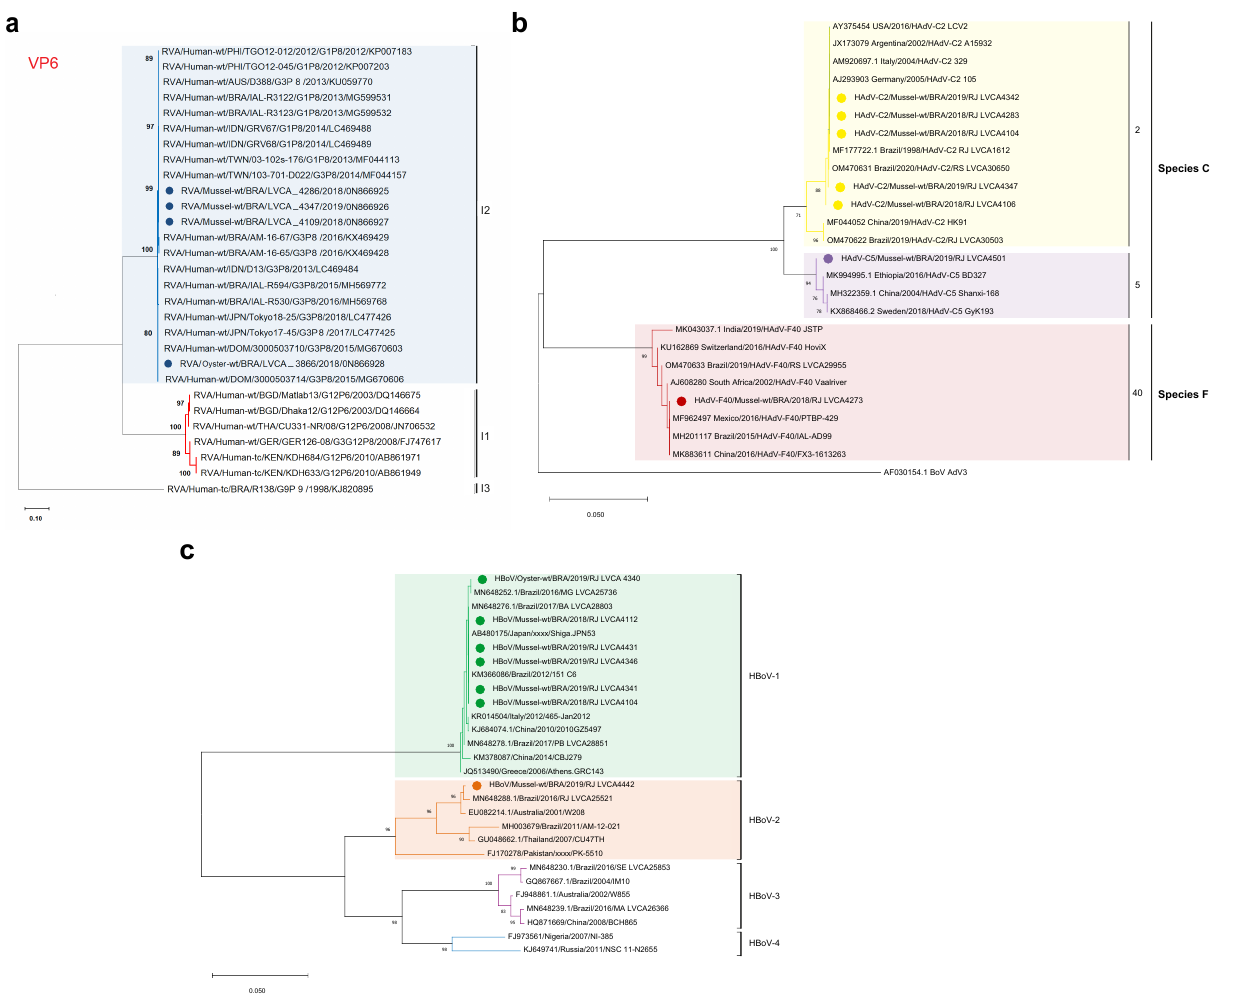
Figure 4. Phylogenetic trees based on ( a ) VP6 nucleotide (nt) of RVA; on ( b ) the hexon gene of HAdV; and on ( c ) VP1 nt of HBoV. RVA strains obtained in this study are marked with a blue-filled circle. HAdV-C2, -C5 and -F40 are marked with a yellow, purple and red-filled circle, respectively. HBoV-1 and -2 are marked with a green- and orange-filled circle, respectively. Reference strains were downloaded from GenBank and labelled with their accession number, country of isolation, year, genotype and register number. Phylogenetic trees were generated in MEGA X software with bootstrap tests of 2000 replicates, based on the Tamura 3-parameter model (best fit model for all viruses). Bootstrap values of ≥ 70% are shown at each branch